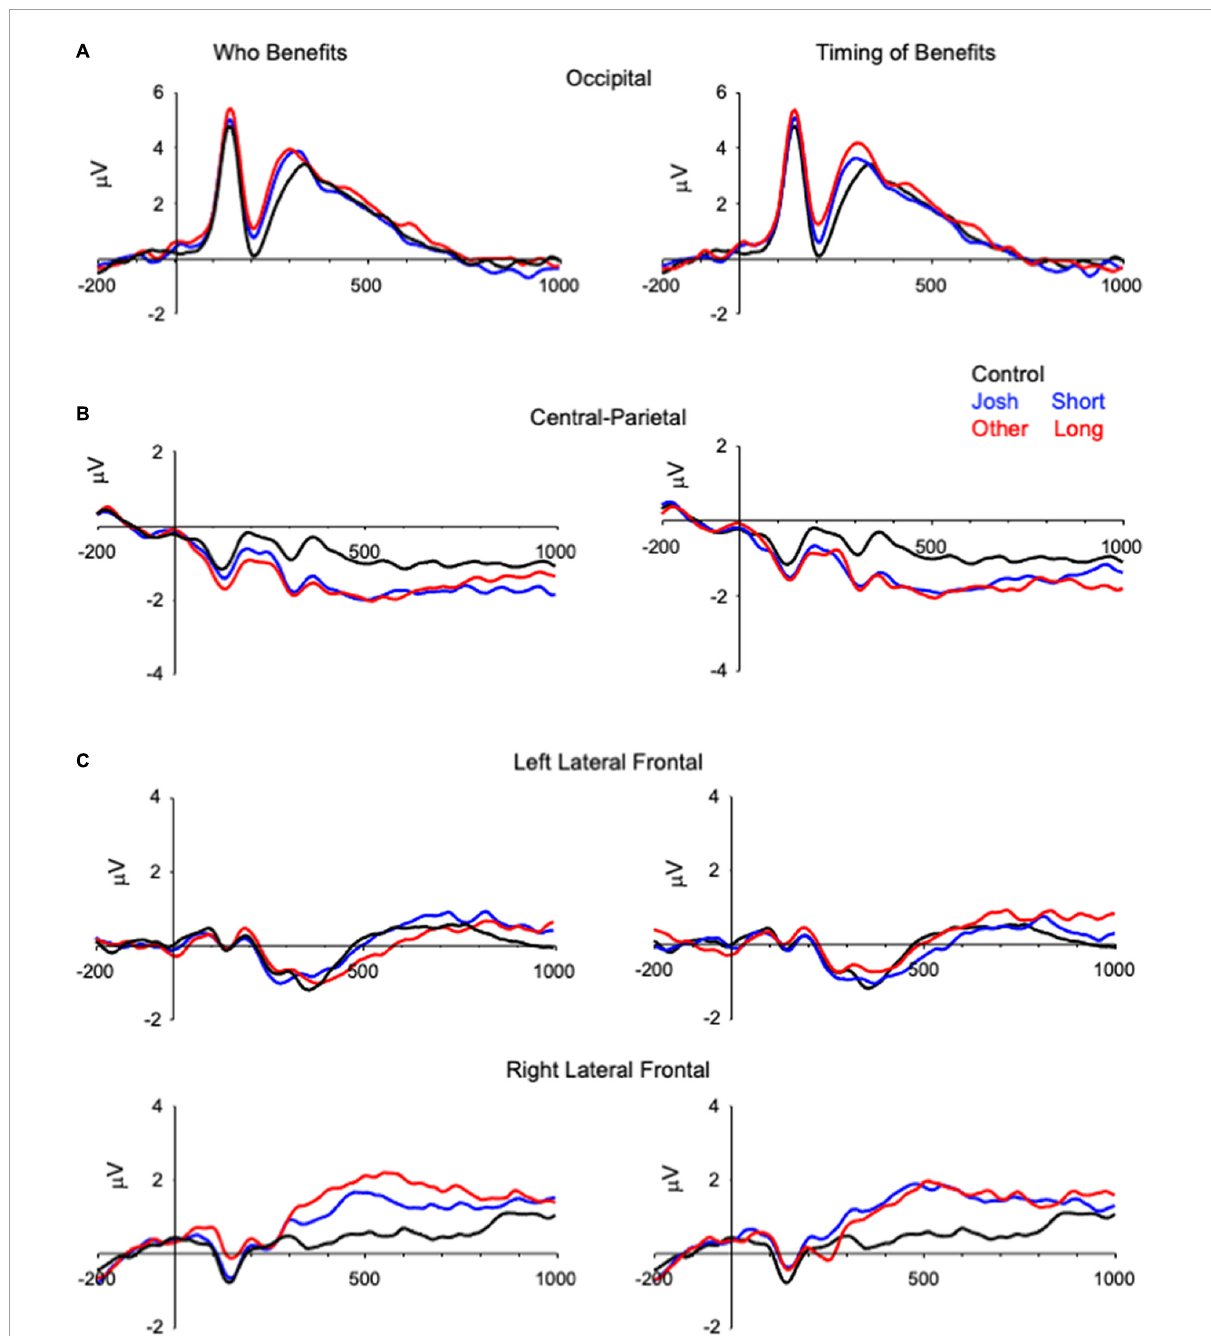
FIGURE1 Grand-averaged ERPs demonstrating differences in the physiology between the two types of trials (i.e., ethical vs. control) that are averaged across the electrodes included in the analyses (e.g., for the N2 the plotted electrode is the average of O1, Oz, O2). The left side of the figure plots Control, Josh, and Other items, and the right side of the figure plots Control, Short and Long delay items. (A) N2, (B) central-parietal negativity, and (C) right frontal-temporal positivity from − 200 ms before onset of the prompt to 1,000 ms after onset of the prompt. The y-axis represents onset of the prompt and the minor x-axis tick marks represent 100 ms